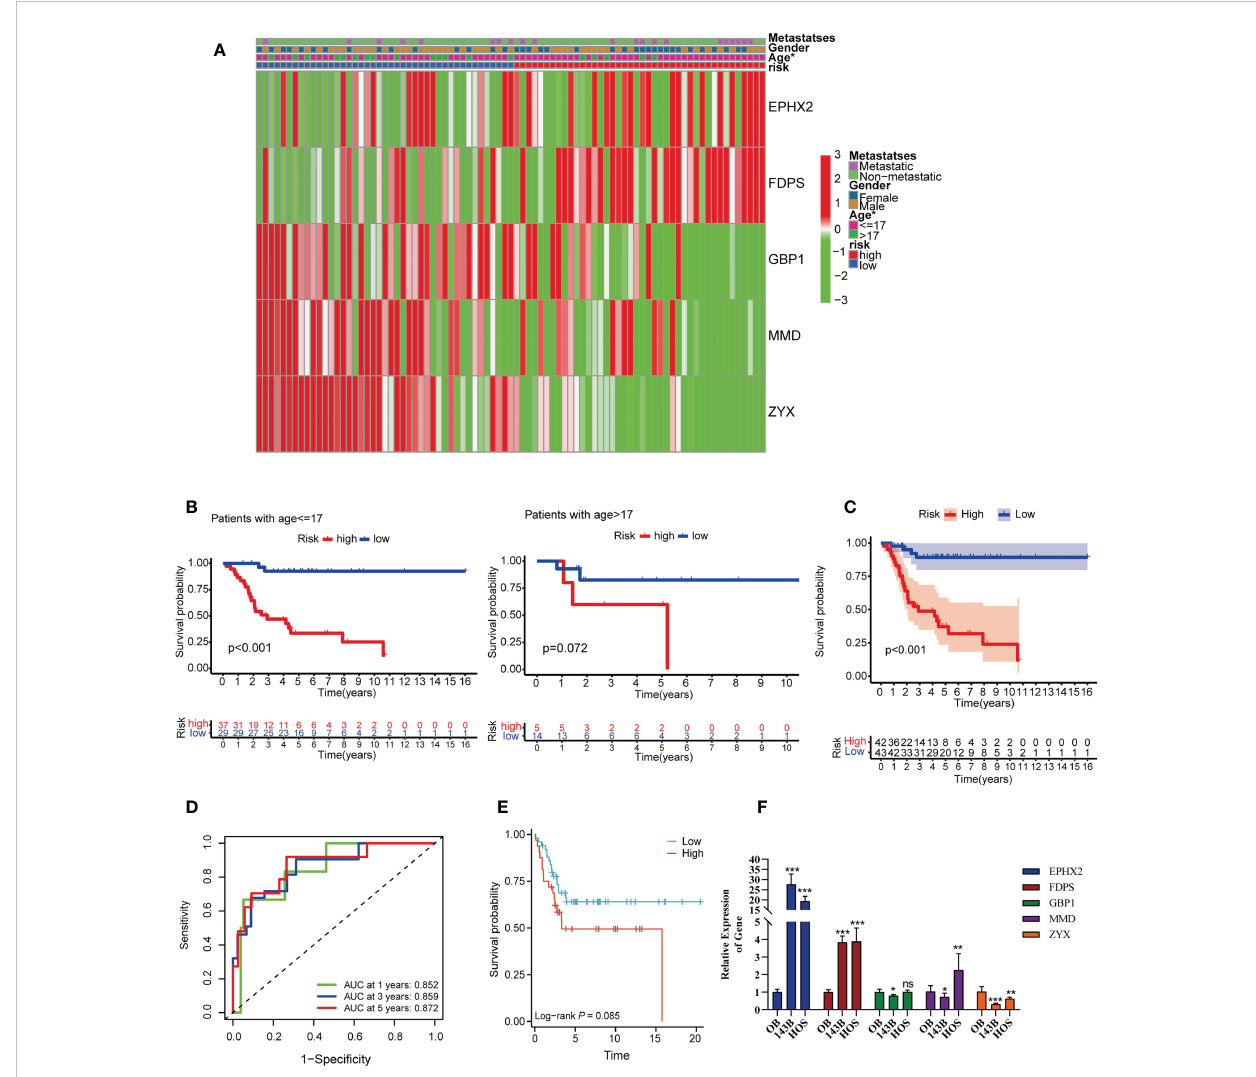
FIGURE 4 Survival analysis and predictive performance evaluation of TILscore. (A) Heat map of the relationship between different clinical phenotypes and two risk groups. (B) 17 years of age as the threshold for survival differences between the two risk groups. (C) Kaplan-Meier curves for survival analysis compared overall survival of OS patients in the high-risk and low-risk groups. (D) TILscore ROC curves predict the risk of death at 1, 3, and 5 years. (E) Kaplan-Meier curves for survival analysis based on external veri fi cation database. (F) The result of RT-qPCR. *p < 0.05; **p < 0.01; ***p < 0.001; ns is for no statistical signi fi